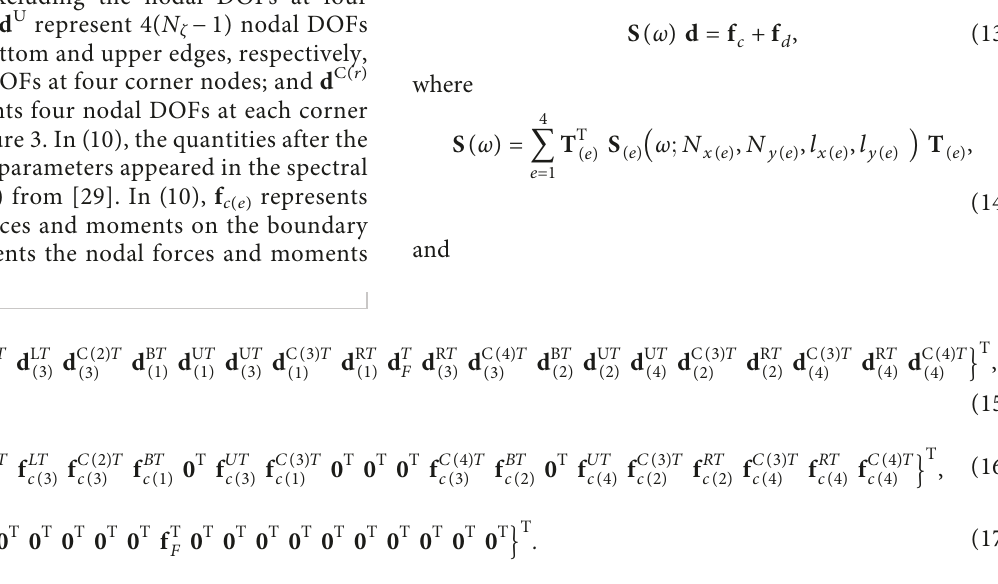
Figure 3: Spectral nodal DOFs for a rectangular finite plate ele- ment,